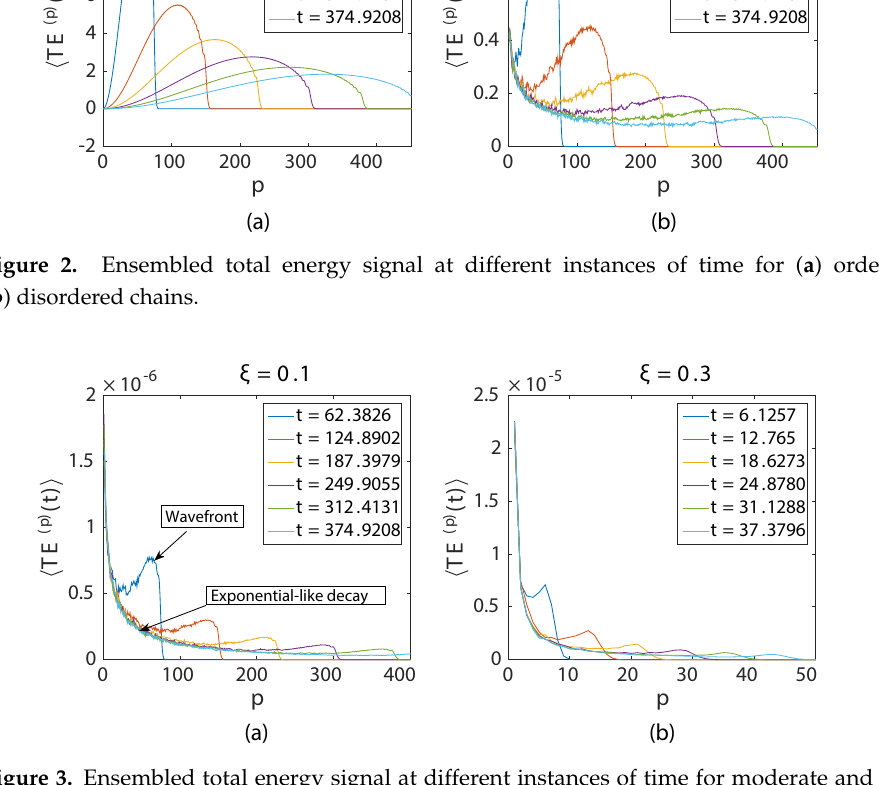
Figure 3. Ensembled total energy signal at different instances of time for moderate and strongly disordered